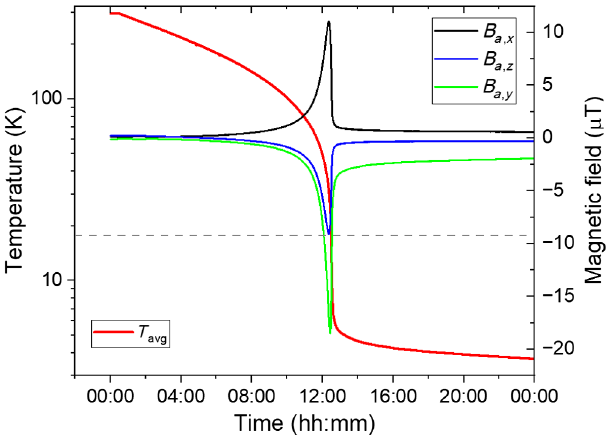
FIG. 22. Average temperature and ambient magnetic field at the cavity equator as a function of time, starting at the beginning of the cooldown, during the first cooldown of the cavity in the HTC. ∼ 17 . 7 K. The dashed line is at T c